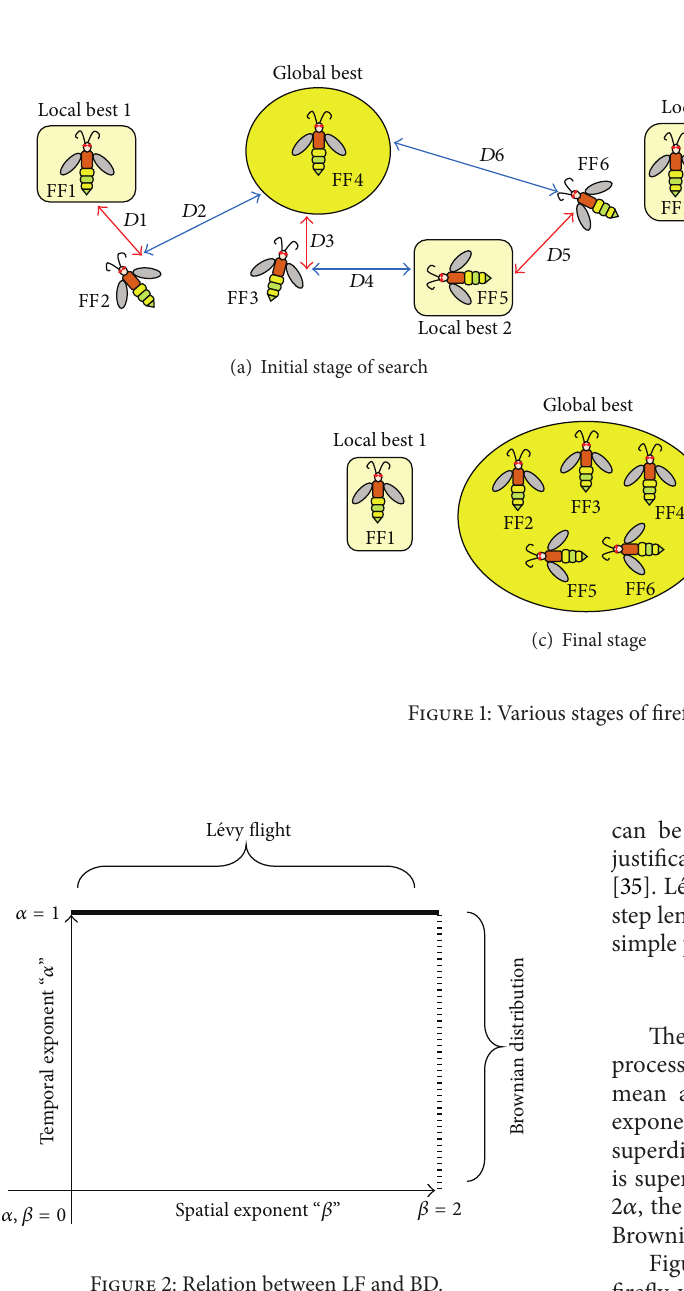
Figure 2: Relation between LF and